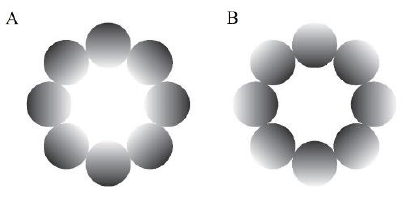
Figure 1. Experimental stimuli. ( A ) The glare illusion, with an increasing luminance gradation from the periphery to the central white region; ( B ) the halo stimulus, with a decreasing luminance gradation from the periphery to the center.